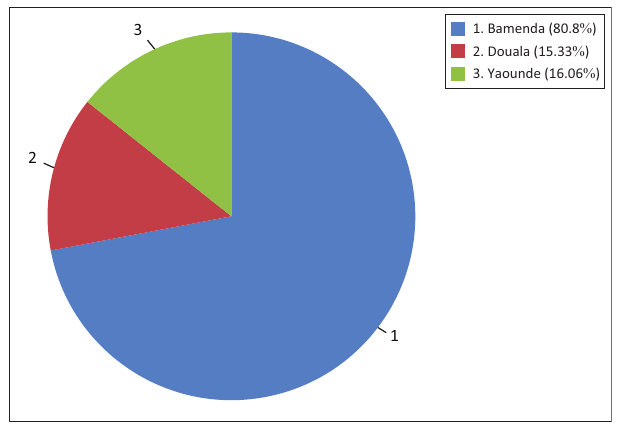
FIGURE 2: Frequencies of participants who never used